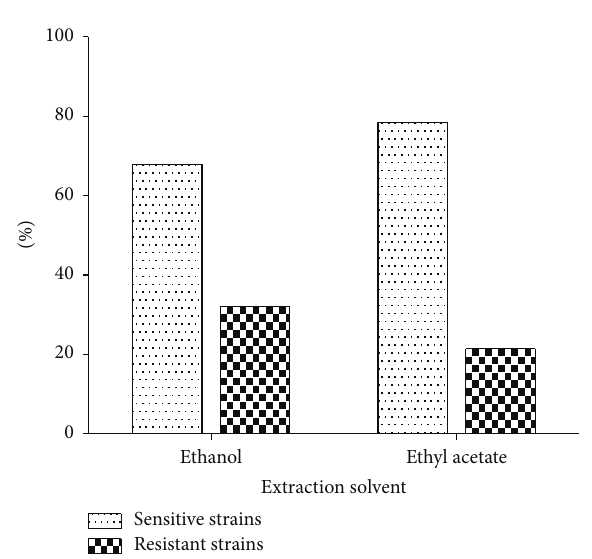
Figure1:Antimicrobialeffectof C.nitida extractson Staphylococcus strains isolated from